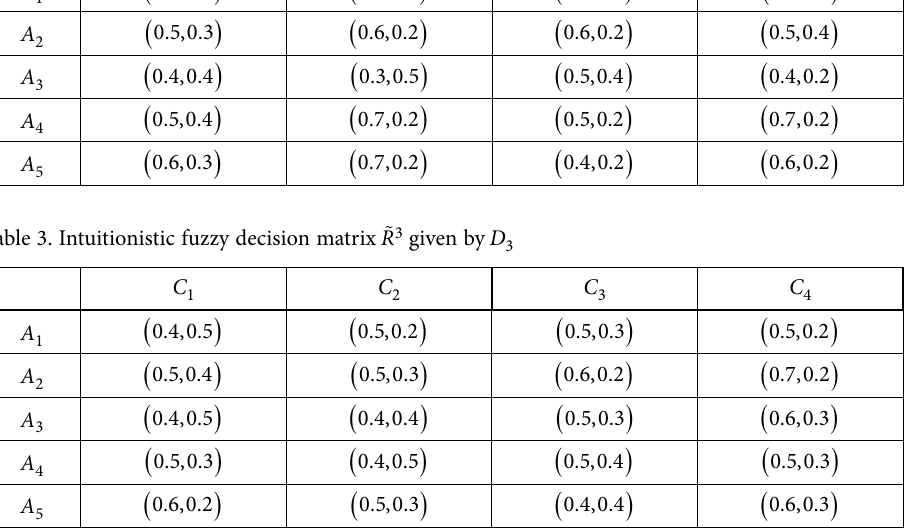
Table 2. Intuitionistic fuzzy decision matrix 2 R  given by 2 D C 1 C 2 C 3 C 4 A 1